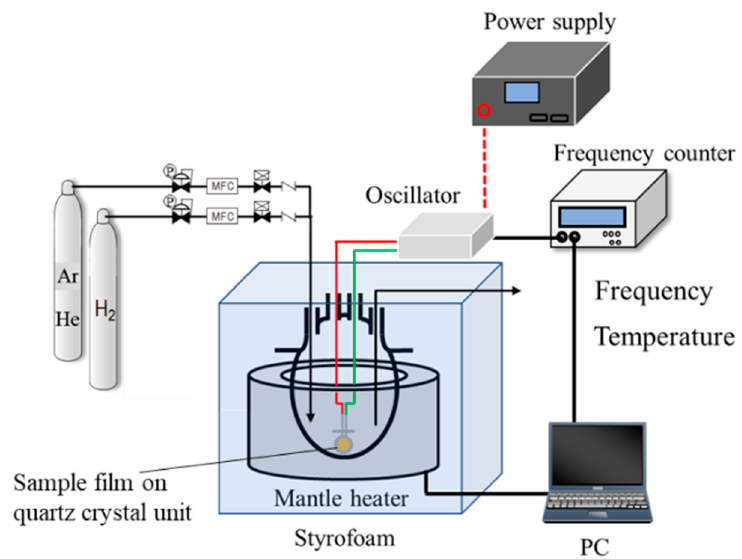
Figure 1. Schematic diagram of the weight change measurement with the quartz crystal microbalance (QCM).